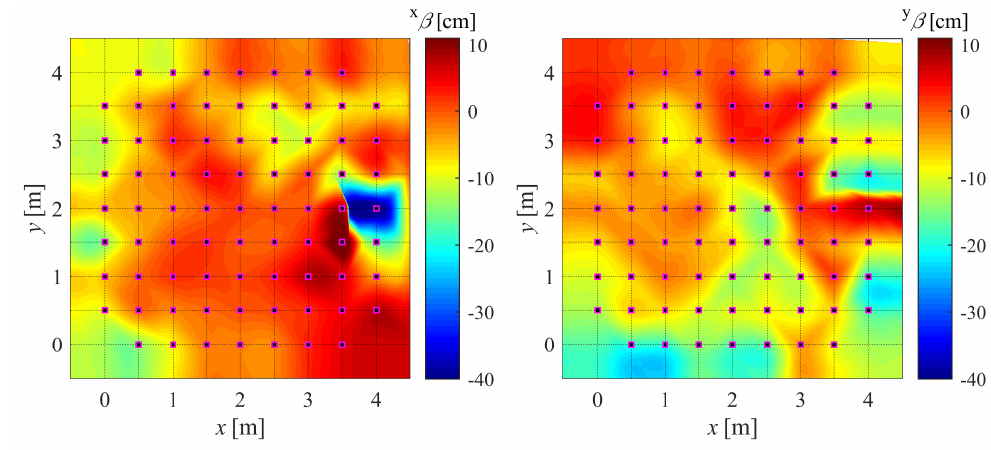
Figure 12. Debiasing function for measured x component ( x β ) and y component ( y β ) of position. For validation, the estimates provided by IPS-2 are compared to those returned by IPS-1 at a predefined set of points (shown in Figure 1) not been previously used